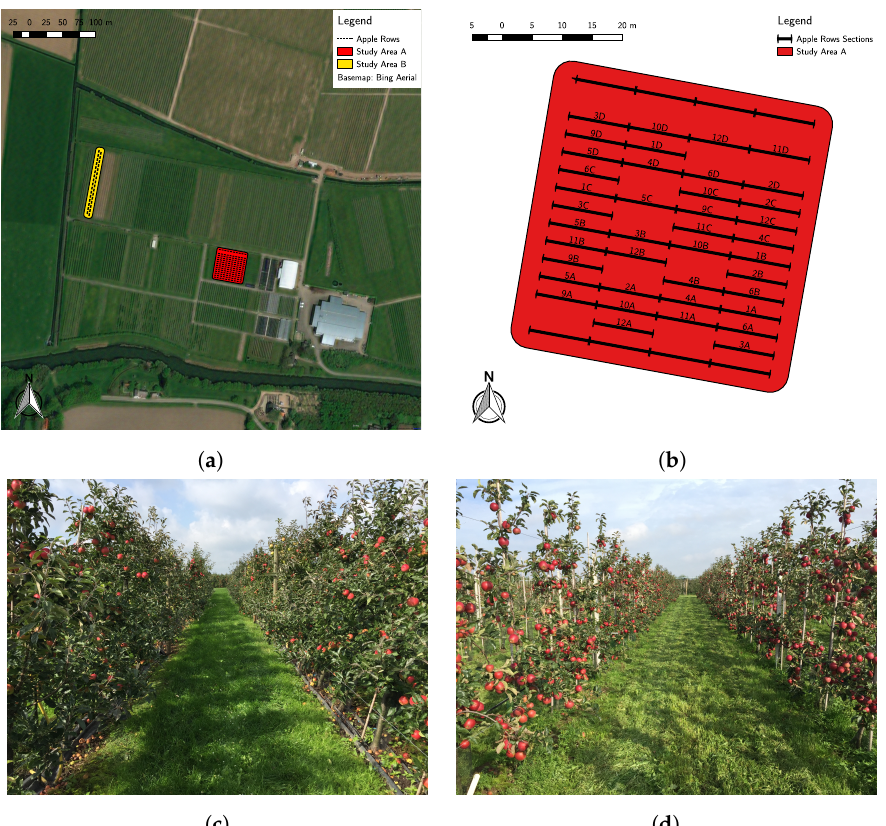
Figure 2. General and detailed map of the study area. ( a ) Map of the selected study areas in Randwijk (A and B). ( b ) Sections of apple lines used for fruit load assessment in Study Area A. Some lines show discontinuities since trees were removed in that section. ( c ) Junami and Golden Delicious cultivar. ( d ) Natyra